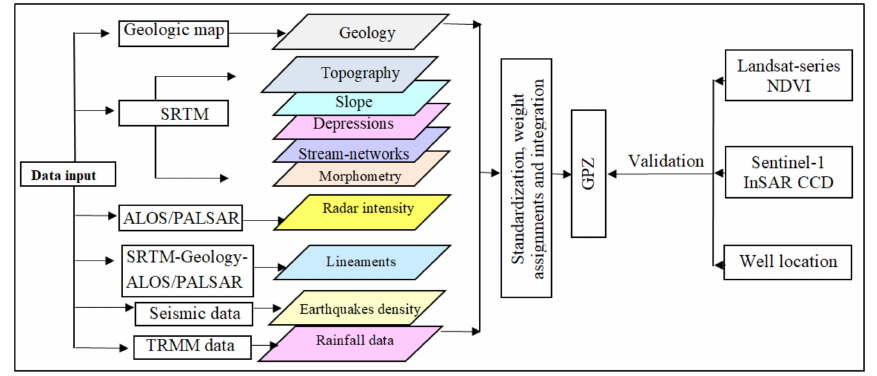
Figure 2. Flow chart showing the data and methods adopted in the present